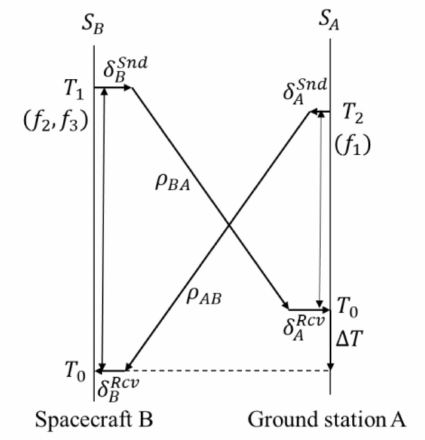
Figure 1. The principle of the two-way time synchronization method with GSLs.